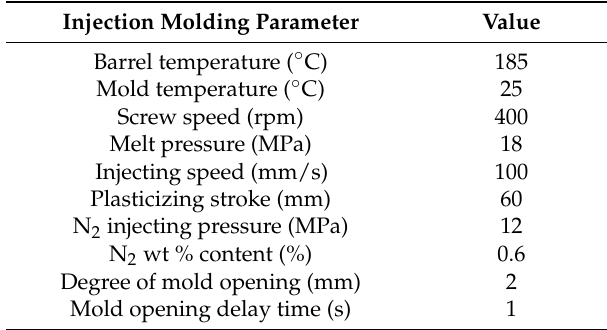
Figure 2. Pressure profiles at different rates of mold opening. Table 1. Processing parameters used in the injection molding of foamed samples.